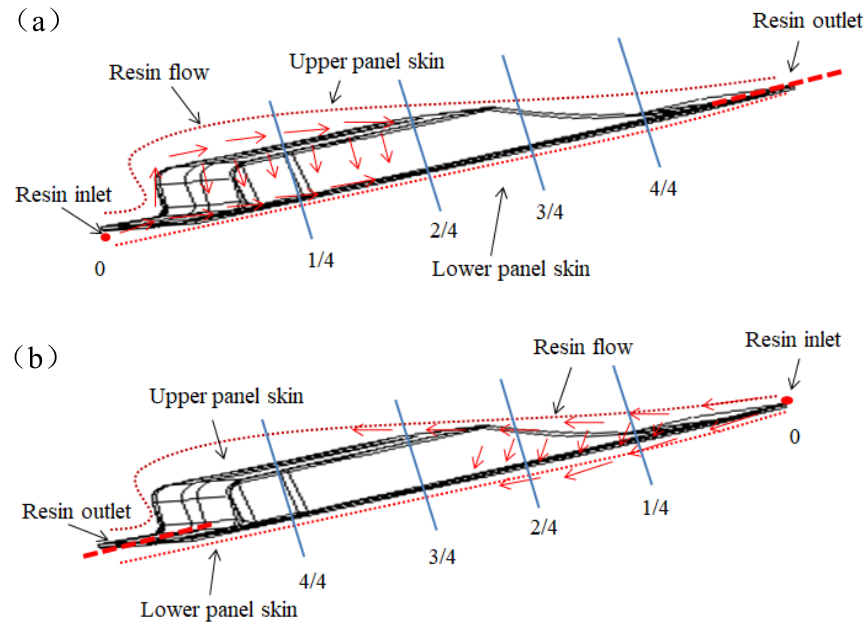
Figure 2. Representation of different resin inlet port on the spoiler. ( a ) Case 1; ( b ) Case 2. Case 1: resin is injected from the thicker side of the spoiler component and flows out from the thinner side.